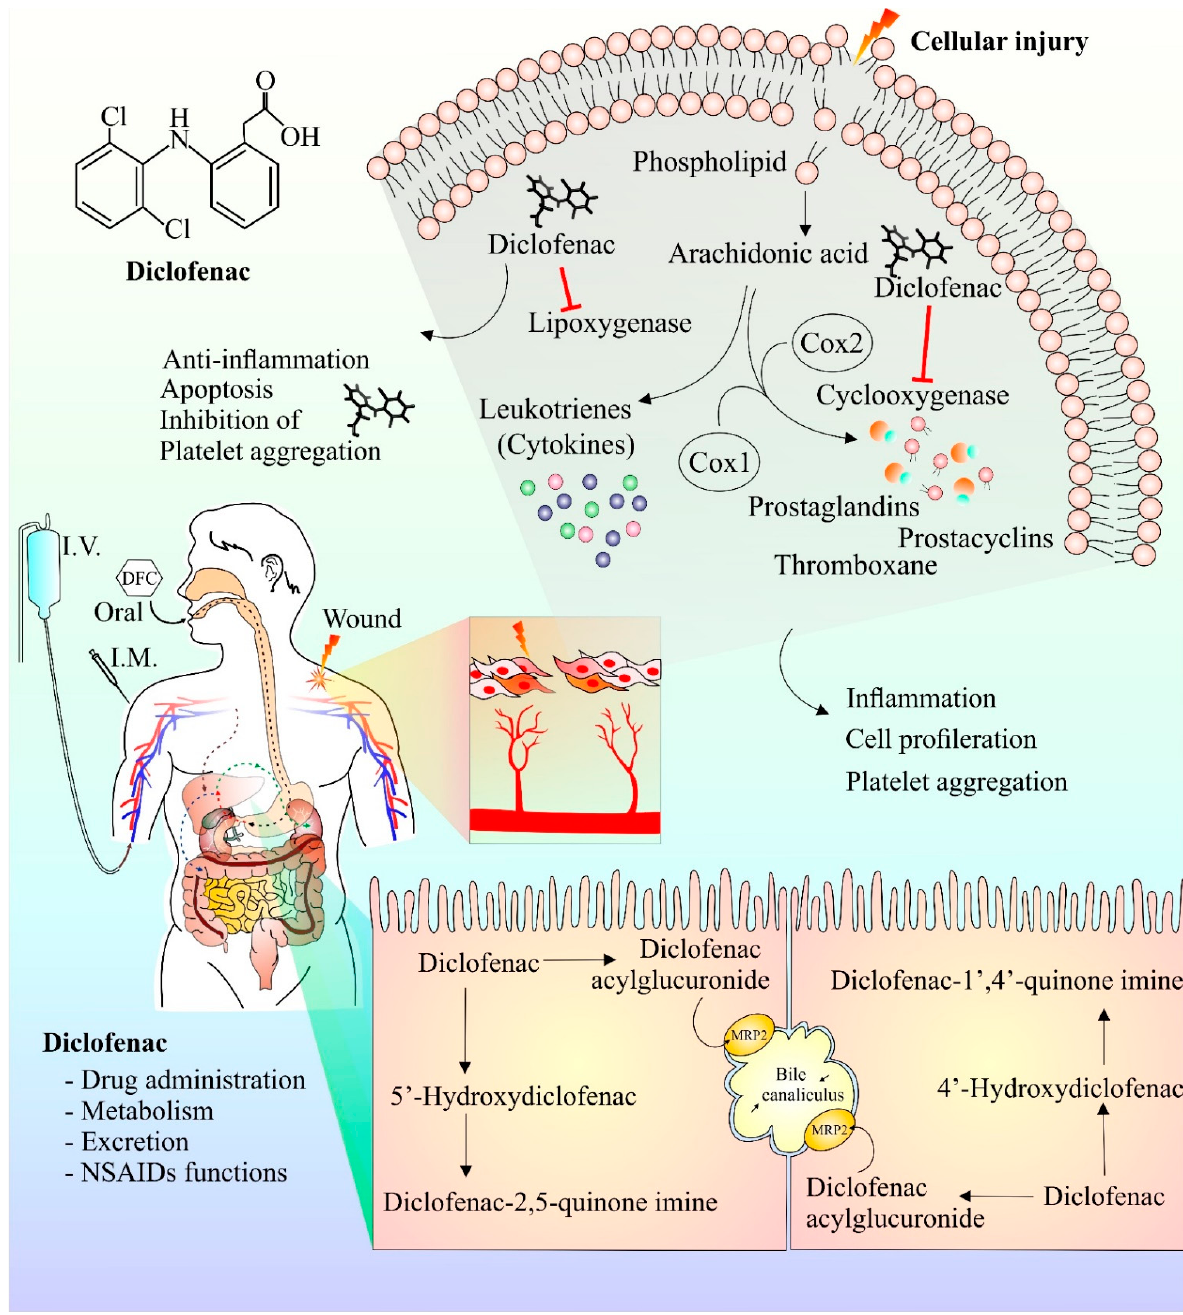
Figure 1. Chemical structure, mechanism of action, mode of drug administration, and metabolism of diclofenac. Cell damage results in release of arachidonic acid, a constituent of plasma membrane. Arachidonic acid in presence of enzyme cyclooxygenase and lipoxygenase is metabolized into pros ‐ taglandins, prostacyclins, and cytokines. These components are responsible for the generation of anti ‐ inflammatory responses at the site of injury, causing pain and inflammation. Inhibition of plate ‐ let aggregation and cell proliferation by diclofenac have also been reported. The anti ‐ inflammatory and analgesic effect of diclofenac is ascribed to its ability to hinder cyclooxygenase and lipoxygenase enzyme actions. Diclofenac metabolism mainly occurs in the liver and the major metabolic compo ‐ nent of diclofenac is 4 ′ hydroxyl diclofenac metabolite. Other minor metabolites such as 5 ′ hydroxy diclofenac are also formed. The activation/formation and inhibition are depicted with arrows and blunt heads, respectively.